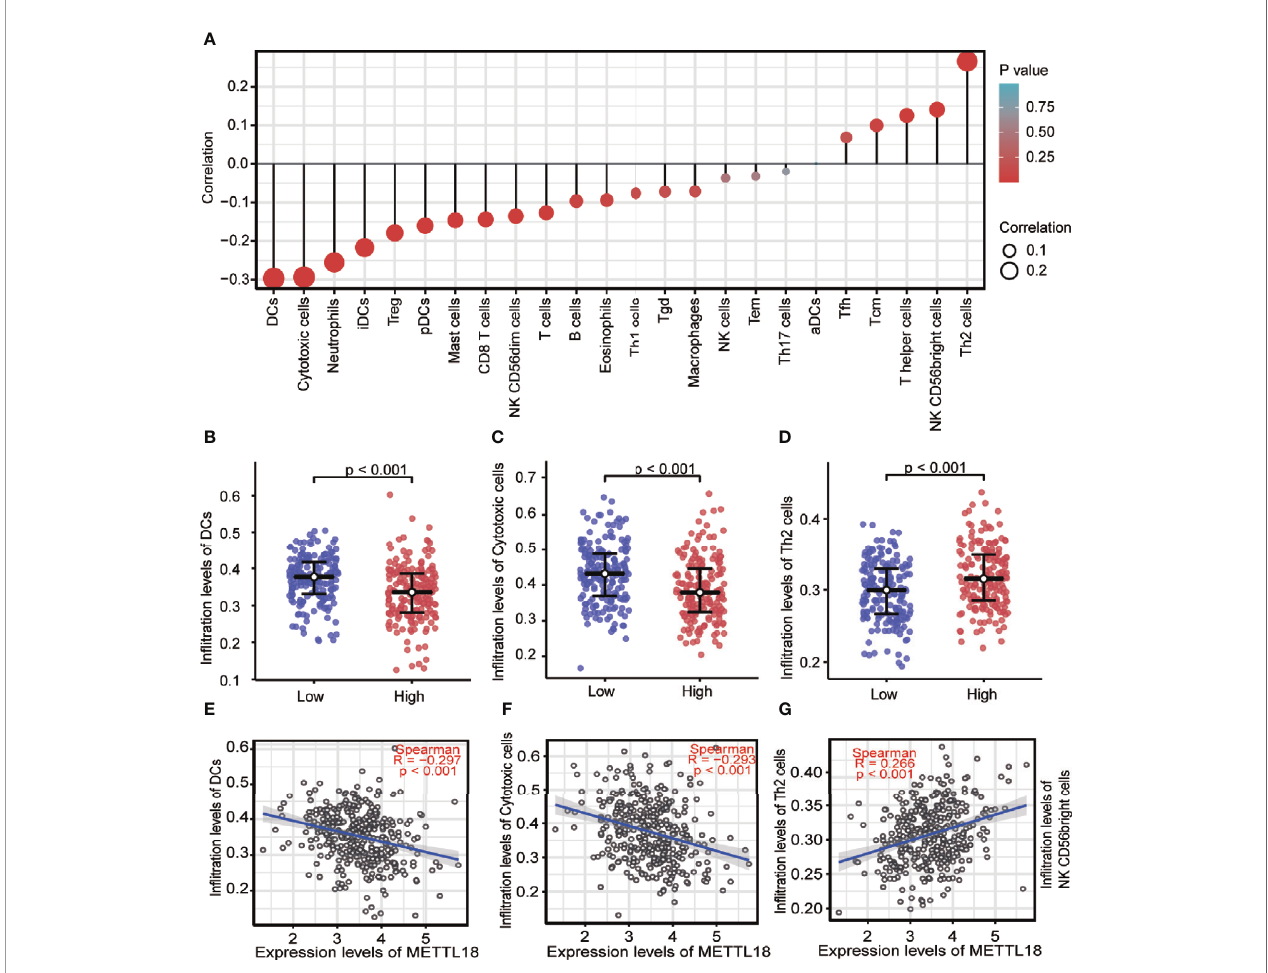
FIGURE 3 | The expression of METTL18 was related to the immune in fi ltration in the tumor microenvironment. (A) Association between the METTL18 expression level and relative abundances of 24 immune cells. The size of dots demonstrates the absolute value of Spearman R. (B – G) Correlation diagrams and scatter plots indicating the differentiation of DCs, Cytotoxic cells, and Th2 cells in fi ltration level between high and low groups of METTL18